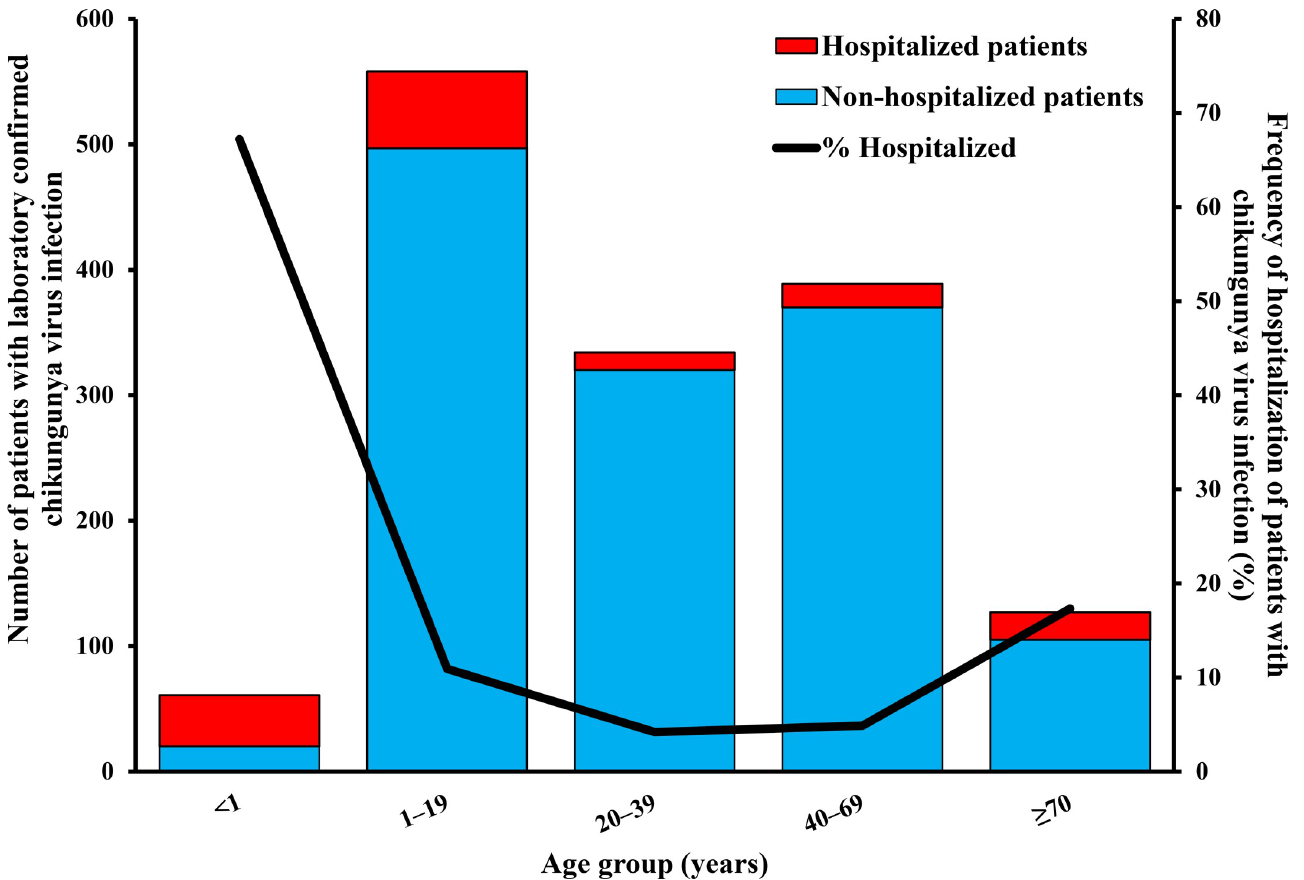
Fig 3. Number and frequency of hospitalization by age group of chikungunya virus-infected patients enrolled in the Sentinel Enhanced Dengue Surveillance System, May–December, 2014.